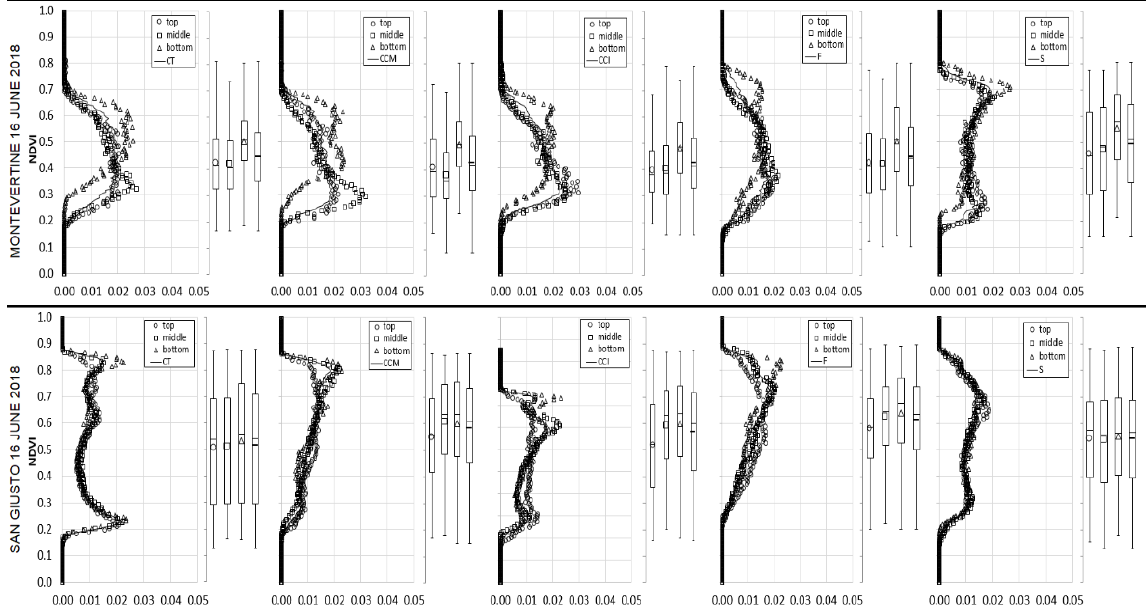
Figure 5. Distribution frequency of the NDVI pixels and boxplots obtained for the entire vine row treatment and for the three subplots (top; middle; bottom) localized along the slope gradient.